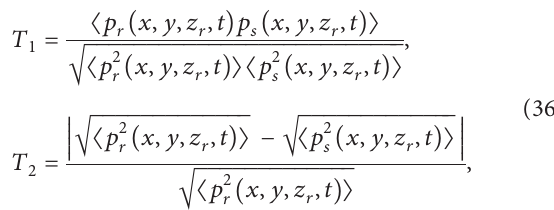
1 and P 2 on different prediction planes when z � r